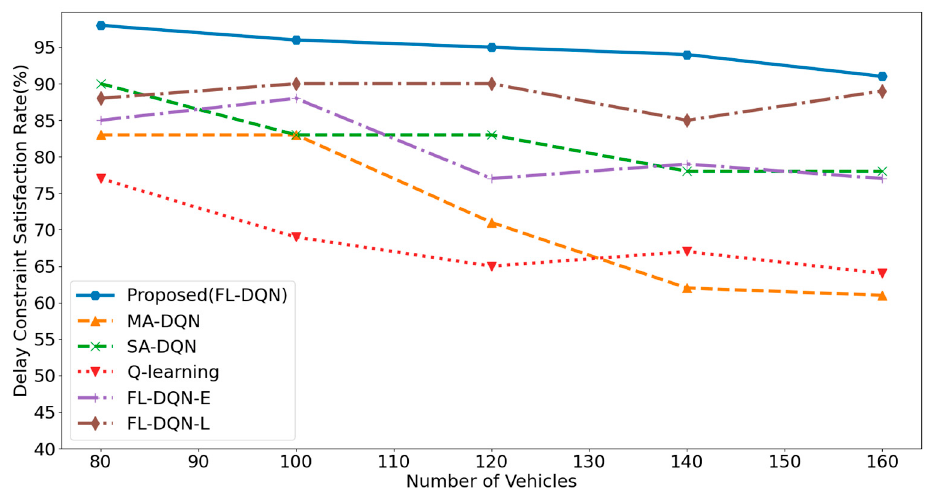
Figure 2. Delay constraint satisfaction rate with varying number of vehicles.